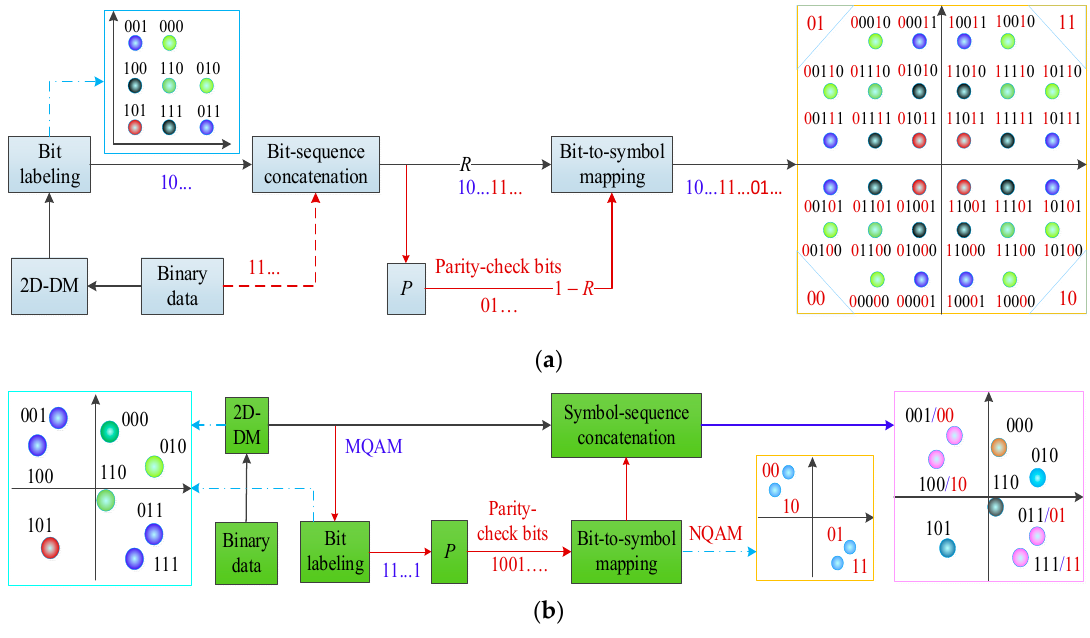
Figure 6. Modified probabilistic shaping (PS) schemes based on ( a ) probabilistic fold shaping, ( b ) universal PS.